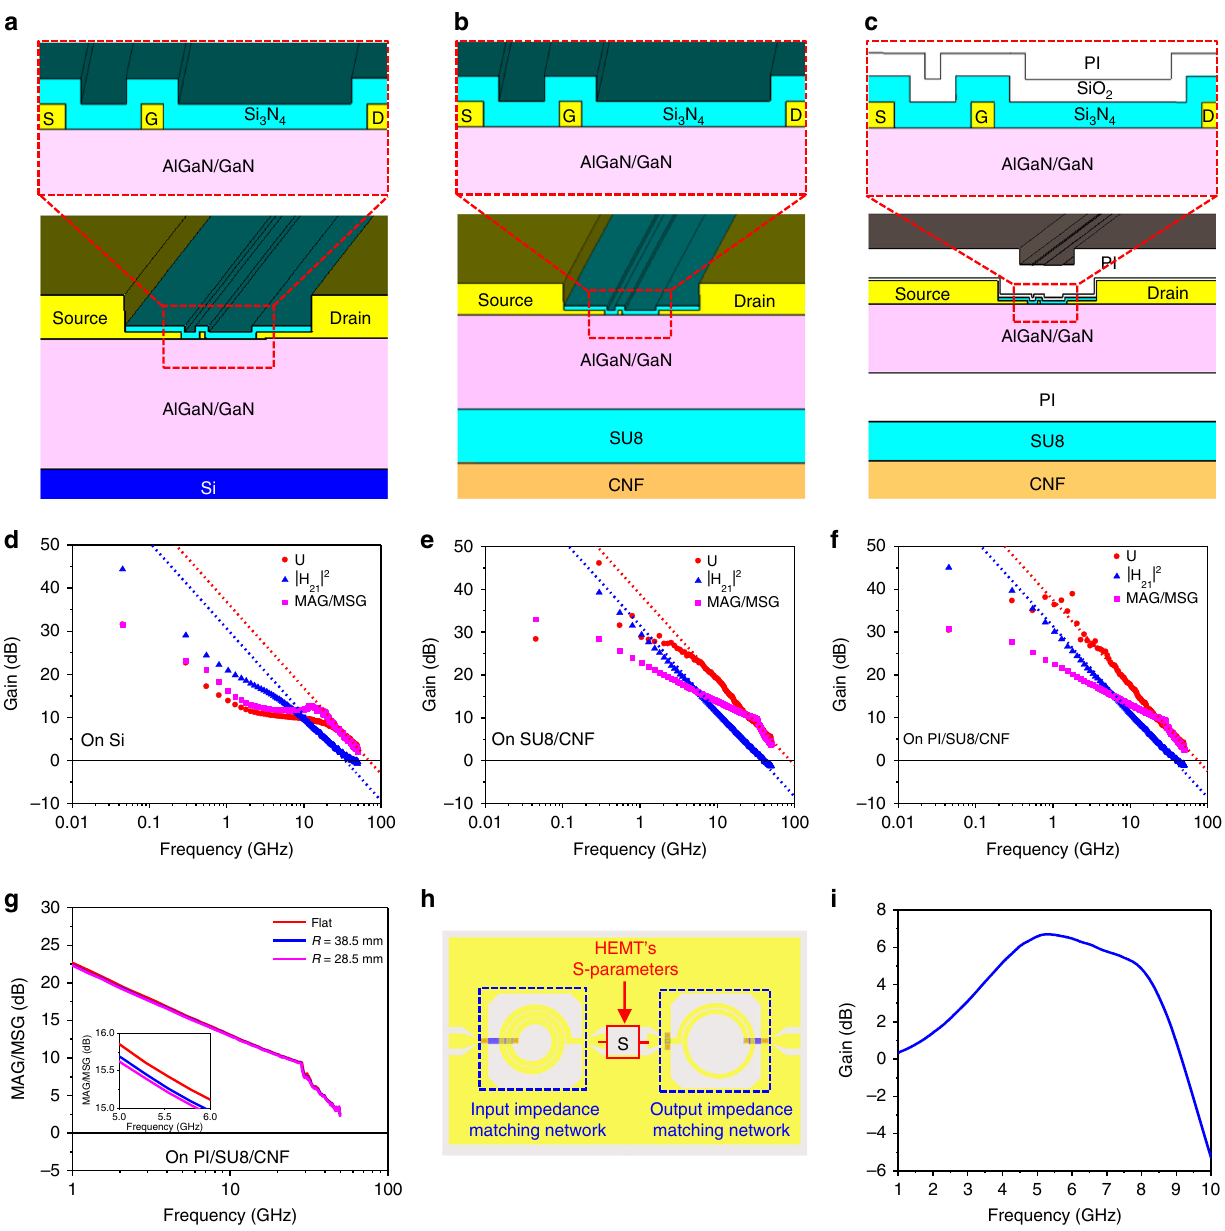
Fig. 3 RF characteristics of membrane AlGaN/GaN HEMTs and f MIC ampli fi er design. a – c Cross-sectional schematic views of AlGaN/GaN HEMTs on Si ( a ), SU8/CNF ( b ), and PI/SU8/CNF ( c ) substrates. The magni fi ed views in a – c show schematic views of the HEMTs ’ active regions on different substrates. d – f Plots of measured values of current gain (|H 21 | 2 ), Mason ’ s unilateral power gain (U), and maximum available gain/maximum stable gain (MAG/MSG) as a function of frequency of HEMTs on Si ( d ), SU8/CNF ( e ), and PI/SU8/CNF ( f ) substrates. g Plots of measured MAG/MSG values of HEMT on PI/ SU8/CNF substrate as a function of frequency under fl at and two bending radii: 38.5 mm and 28.5 mm). The inset is a detailed view of the MAG/MSG curves from 5 GHz to 6 GHz. h Layout of simulated f MIC ampli fi er. The ampli fi er simulations were performed by combining electromagnetic simulations of passive components with measured S-parameters of HEMT on PI/SU8/CNF substrate. i Simulated small-signal gain curve of the ampli fi er as a function of